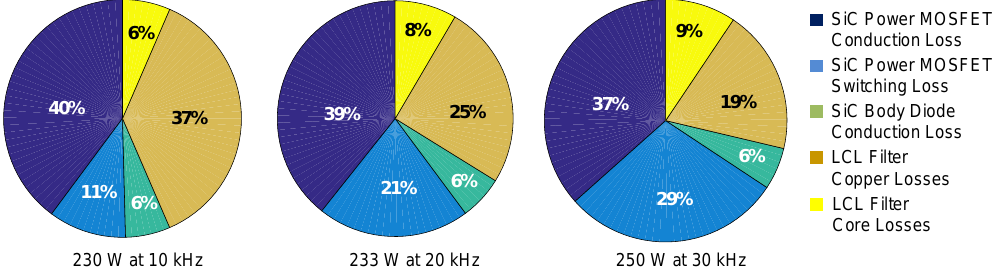
Figure 8. Power loss components of solar inverter for different switching frequencies at P o = 22.3 kW. Numerical values are